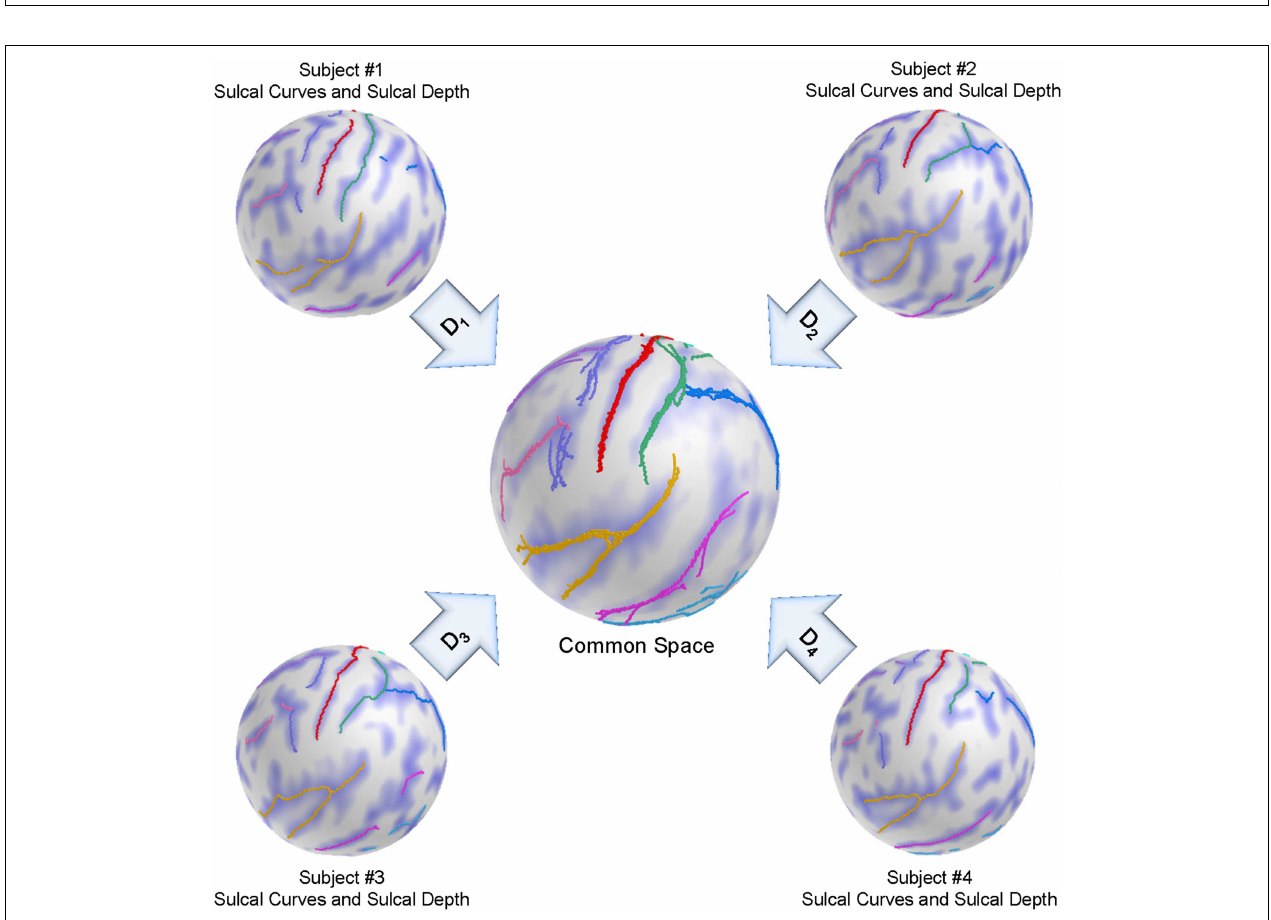
FIGURE 4 | Schematic overview of the group-wise registration. An initial correspondence for each subject is established by our pair-wise registration. The deformed sulcal curves and depth maps are mapped